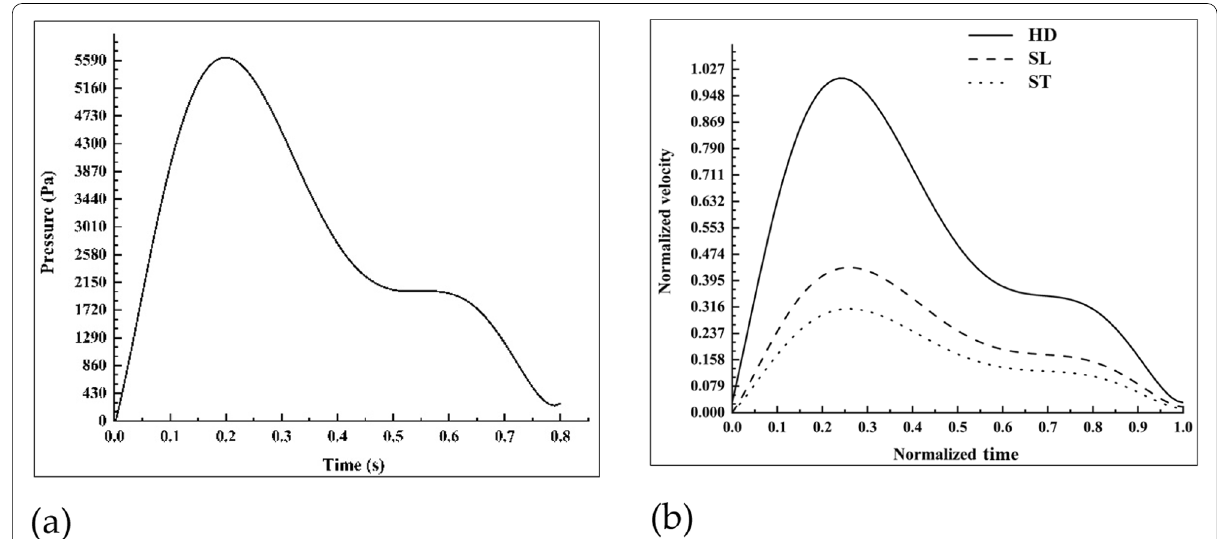
Fig. 4 Various applied waveforms in the fluid domain. a : Outlet pulse pressure waveform; b : Inlet velocity waveform for different